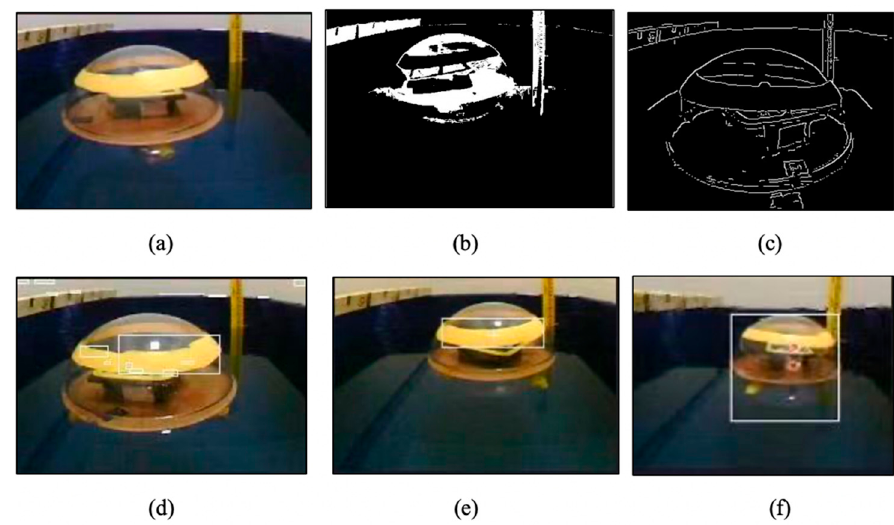
Figure 30. Comparison of two image recognition algorithms. ( a – c ) The feature point recognition algorithm; ( d – f ) The threshold segmentation algorithm.